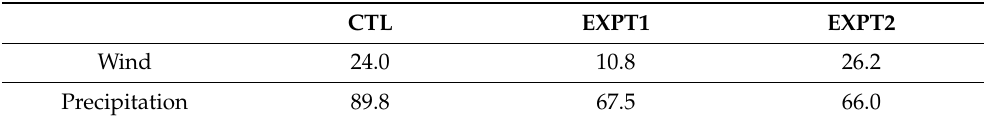
Figure 8. The mean cross sections of the wind (m s − 1 ) and water vapor flux (g s − 1 hPa − 1 cm − 1 ) from 1 to 12 July along Figure 7a for ( a ) CTL, ( b ) EXPT1, and ( c ) EXPT2. The dashed purple vertical lines indicate the extent of the Poyang Lake area. The Y -axis is the height in kilometers. Table 2. The domain-averaged wind speed (m s − 1 ) and precipitation (mm) in Poyang Lake. The domain for calculating the wind speed is between the purple vertical lines in Figure 8 and the domain for calculating the precipitation is shown in Figure